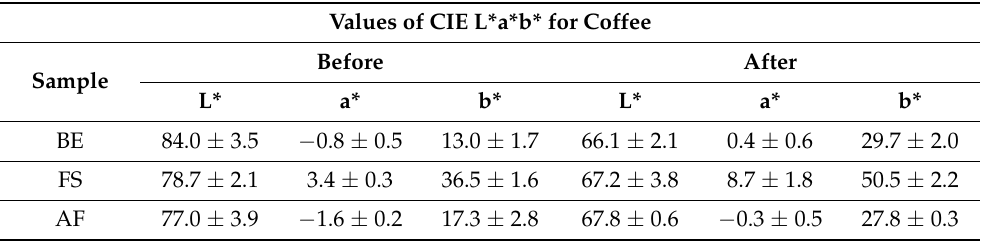
Table 4. Mean ± standard deviation values recorded for CIE L*a*b*, before and after immersing the specimens in the red wine solution.